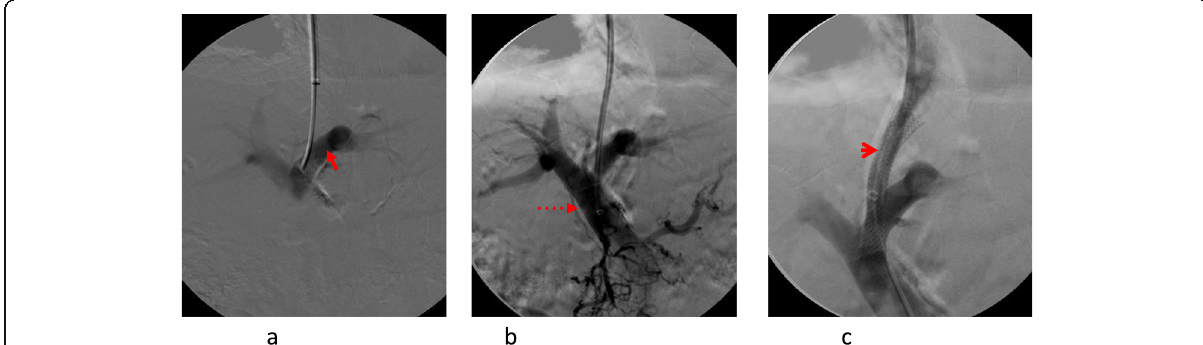
Fig. 2 TIPS case in the TIPS-LPV group. The sheath catheter containing the needle (arrow) was advanced inside the left portal (arrow) with limited left portography ( a ). Main portal (interrupted arrow) venograhy was done ( b ). The delivered Wallstent (arrowhead) was inserted with an apparent straight course and good flow shunting from left portal to cava ( c